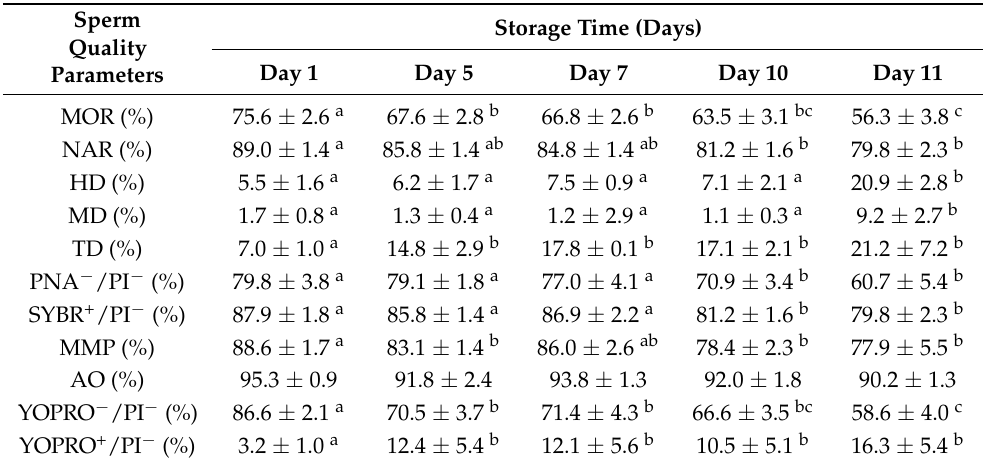
D1. Table 1. The effect of storage time (days) on the quality parameters of red deer epididymal spermatozoa ( n = 11) stored in a liquid state at 5 ◦